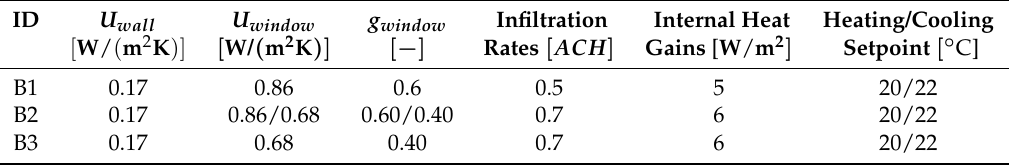
Table 3. Inputs for building energy